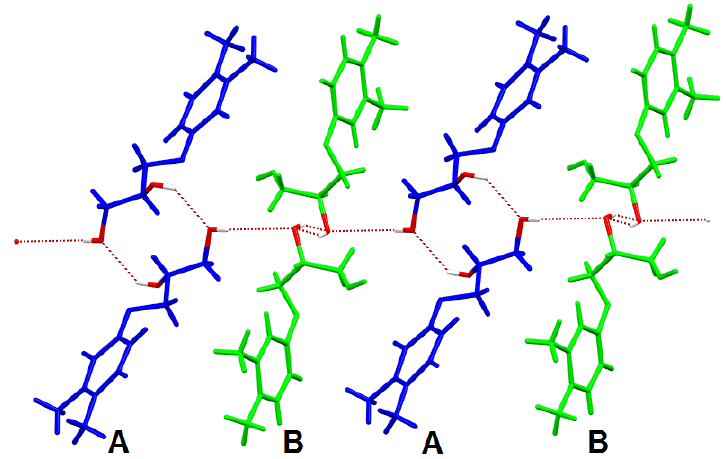
Figure 11. The principal supramolecular motif in β - rac - 1 crystals.